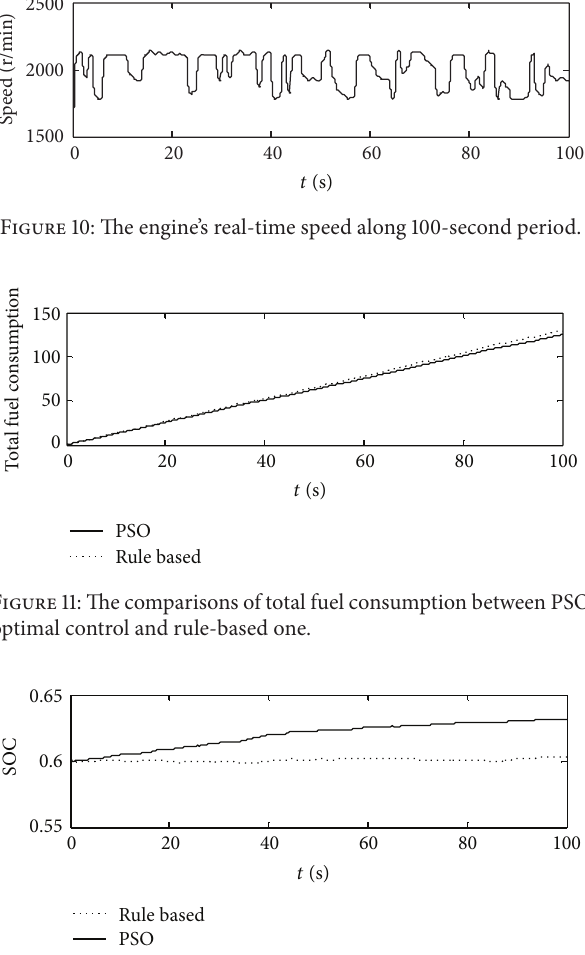
Figure 8: The motor’s performance using optimum engine’s points as commands.